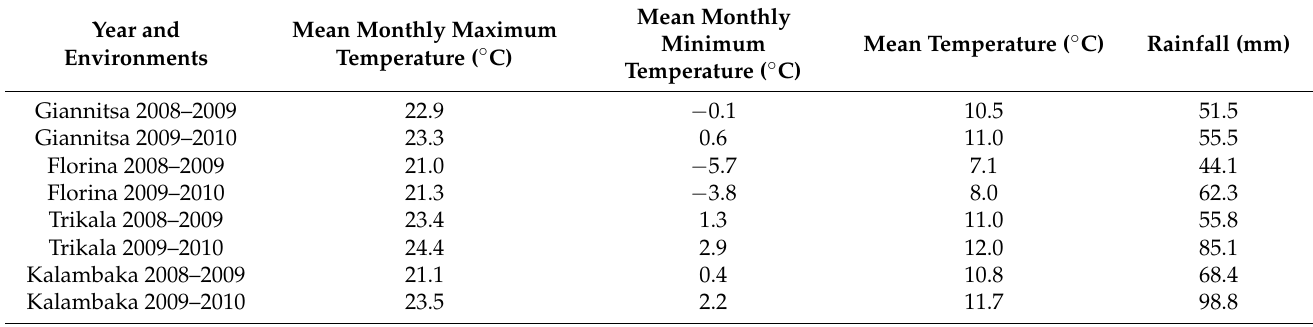
Table 8. Climatic conditions for the examined environments during the cultivation period